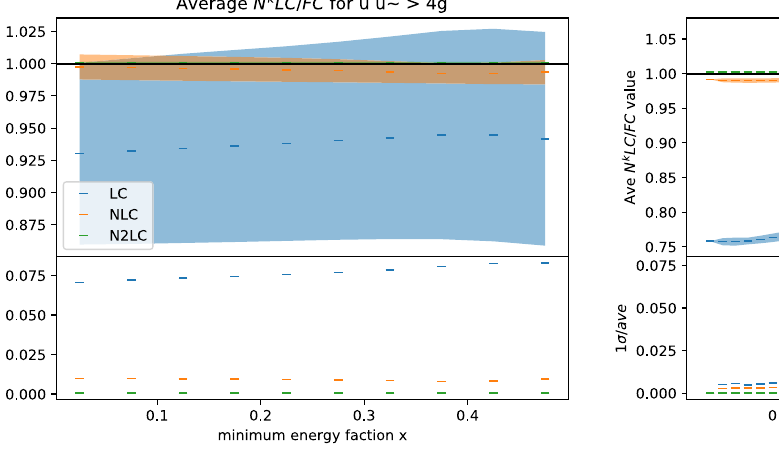
Fig. 8 Same as Fig. 7 but for the process u ¯ u → 4 g